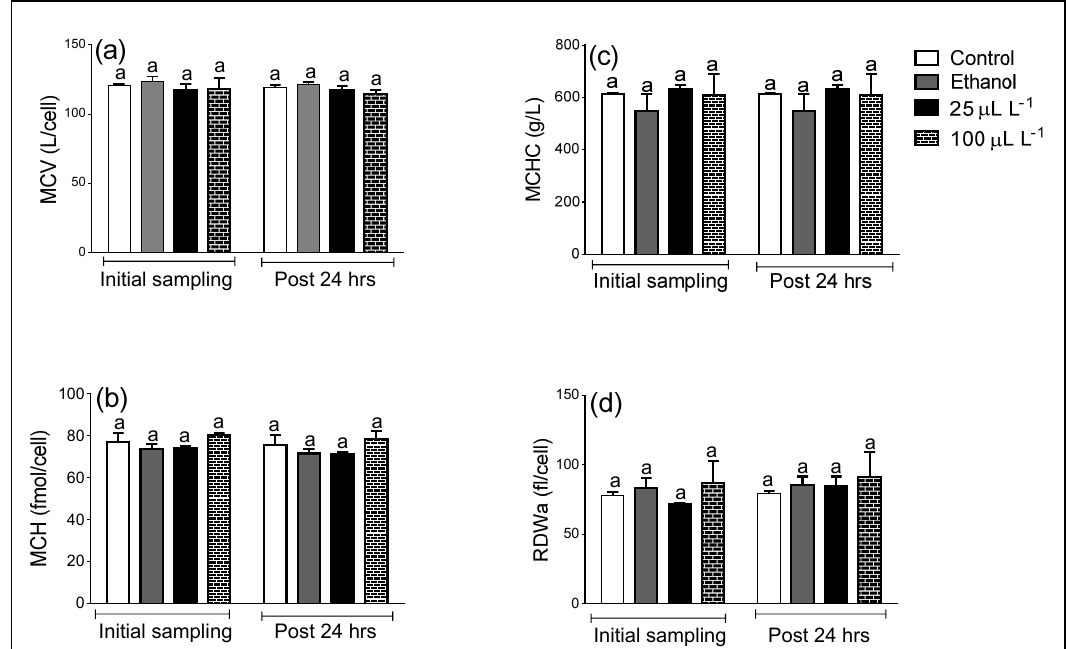
Figure 4. MCV ( a ), MCH ( b ), MCHC ( c ), and RDW a ( d ) of Mozambique tilapia ( Oreochromis mossam- bicus ) subjected to two oregano concentrations (25 and 100 µ L L − 1 ), ethanol, and a control (water only). These parameters were sampled at 0 h and after 24 h. Values are given as mean ± standard error ( N = 3), and different lowercase letters indicate significant differences between treatment groups within a sampling time (0 h or 24 h) using one-way ANOVA and Tukey’s multiple comparison